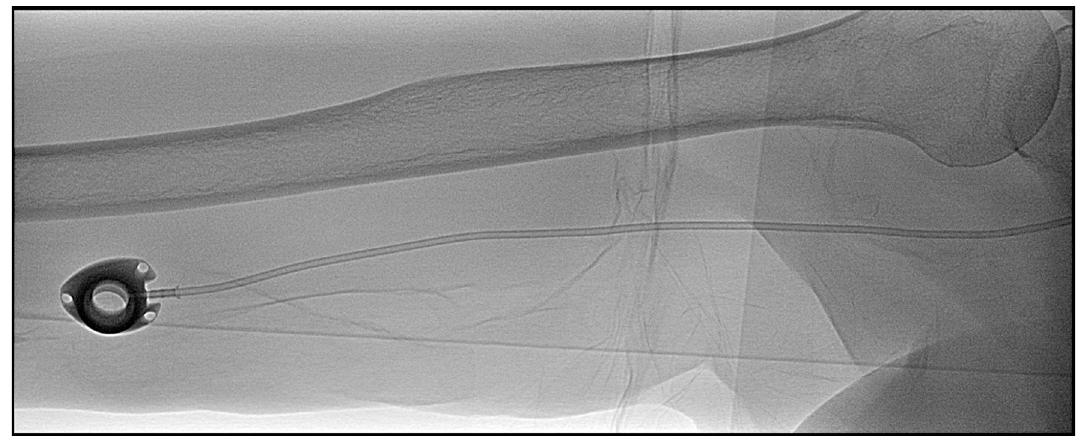
Fig 2. Bard Titanium SlimPort TM . Fluoroscopic image of a Bard Titanium SlimPortTM with a 6F single lumen polyurethane catheter in typical location at the distal upper arm.